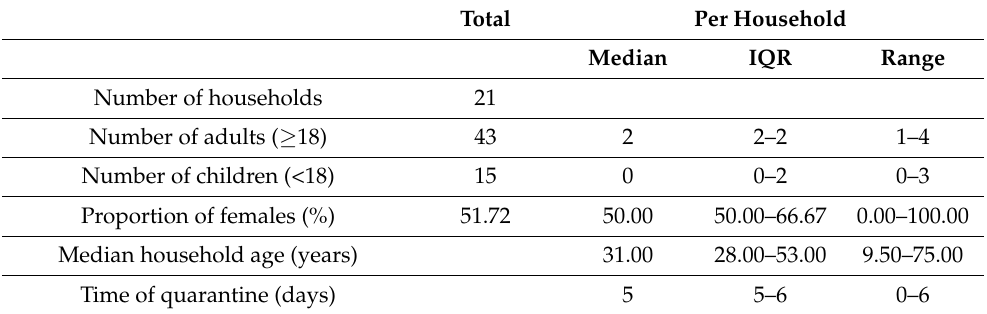
Table 1. Household data.